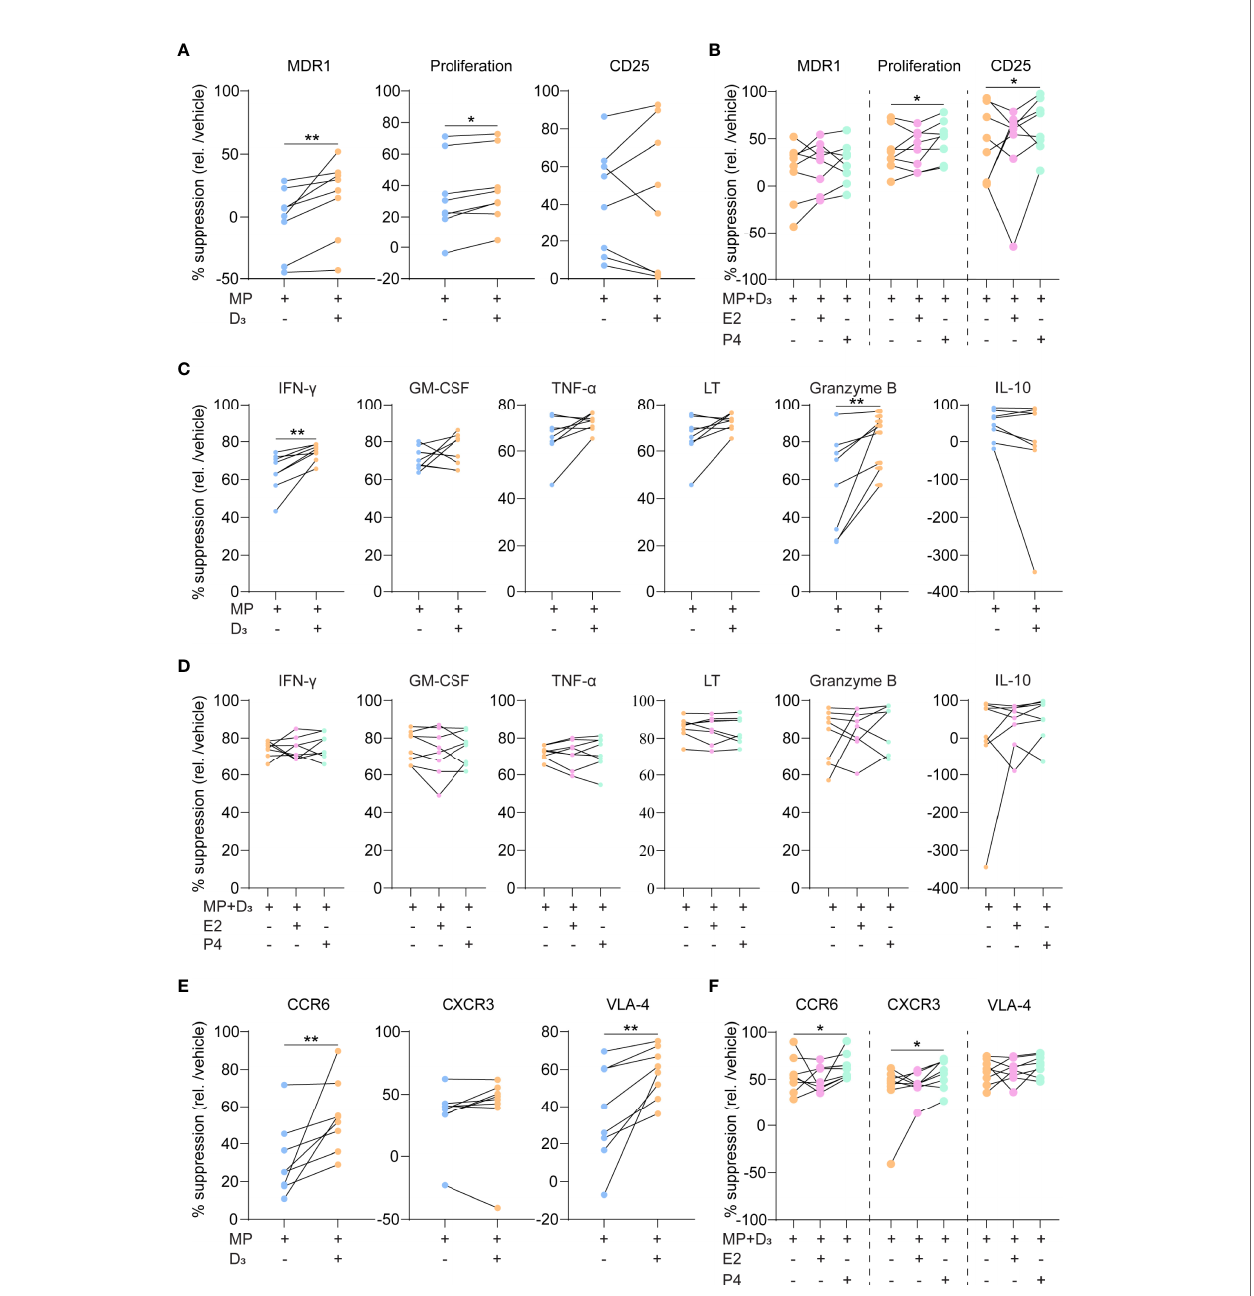
FIGURE 2 | The suppressive capacity of steroid hormone cocktails on glucocorticoid-resistant Th17.1 cells. (A) MDR1 expression, proliferation rates (CFSE - ) and CD25 surface expression (MFI) by healthy donor anti-CD3/CD28-stimulated Th17.1 cells exposed to MP with and without D 3 as determined by fl ow cytometry ( n = 8). Percentages are relative to their appropriate vehicle control. (B) The same parameters as in A) for healthy donor anti-CD3/CD28-stimulated Th17.1 cells exposed to MP+D 3 with and without E2 or P4 as determined by fl ow cytometry ( n = 8). Percentages are relative to their appropriate vehicle control. (C) Amount (pg/ml) of IFN- g , GM-CSF, TNF- a , LT, granzyme B, and IL-10 measured in the supernatants of healthy donor anti-CD3/CD28-stimulated Th17.1 cells exposed to MP with and without D 3 as determined by Luminex ( n = 8 per group). (D) Amount (pg/ml) of IFN- g , GM-CSF, TNF- a , LT, granzyme B, and IL-10 measured in the supernatants of healthy donor anti-CD3/CD28-stimulated Th17.1 cells exposed to MP+D 3 with and without E2 or P4 as determined by Luminex ( n = 8 per group). (E) CCR6, CXCR3 and VLA-4 surface expression on healthy donor anti-CD3/CD28-stimulated Th17.1 cells exposed to MP with and without D 3 as determined by fl ow cytometry ( n = 8). Percentages are relative to their appropriate vehicle control. (F) The same parameters (as in E) for healthy donor anti-CD3/CD28-stimulated Th17.1 cells exposed to MP+D 3 with and without E2 or P4 as determined by fl ow cytometry ( n = 8). Percentages are relative to their appropriate vehicle control. Data were compared using either Wilcoxon rank-sum or (D) Friedman tests with the false discovery rate of Benjamini, Krieger and Yekutieli correction. * p < 0.05 and ** p < 0.01. ” , “ E2, Estradiol ” ; “ MFI, median fl uorescence intensity ” ; “ MP, methylprednisolone ” and “ P4, progesterone ” “ D 3 = 1,25(OH) 2 D 3